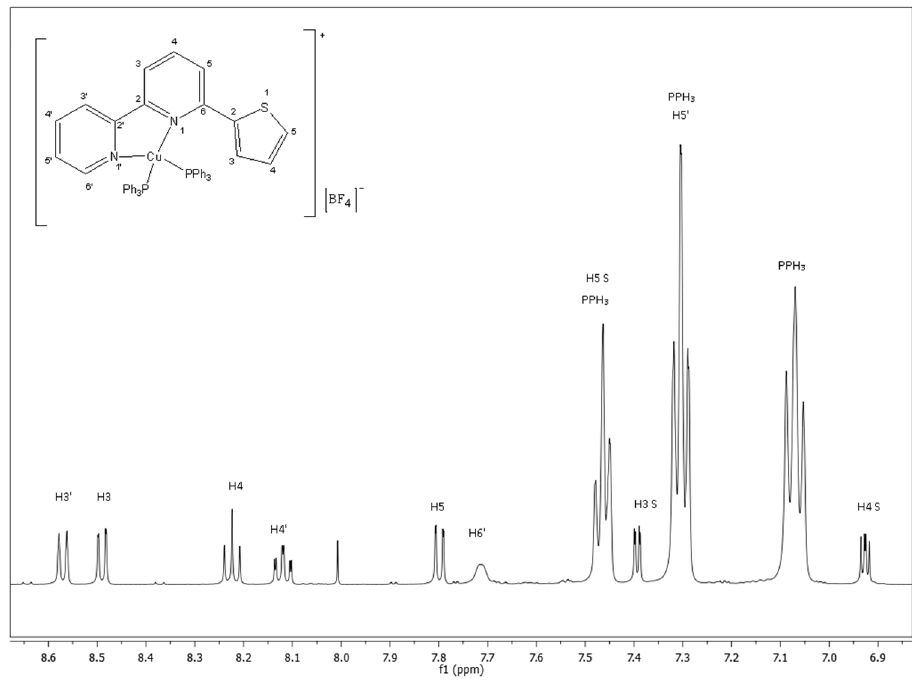
Figure 1. 1 HNMR spectrum of [CuL(PPh 3 ) 2 ][BF 4 ] ( 1 ) in acetone-d 6 (500 MHz, 298K). Table 1. 1 H NMR data ( δ , ppm) for L and the complex 1 ([CuL(PPh 3 ) 2 ][BF 4 ]).